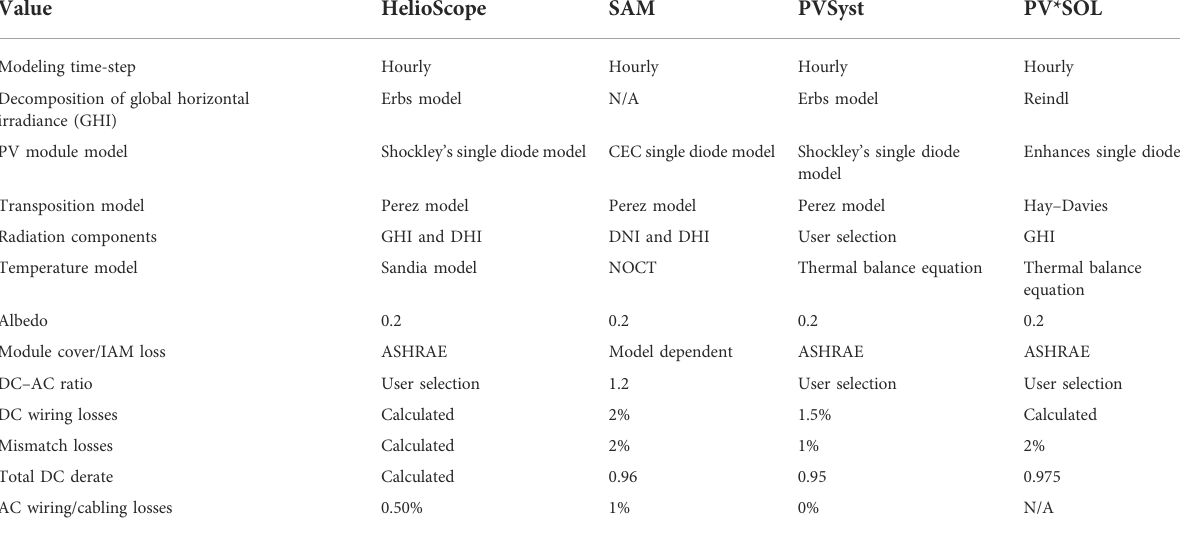
TABLE 2 Comparison of HelioScope with other PV system simulation software (Tamoor et al., 2022).